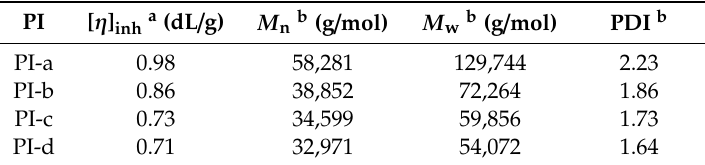
Table 1. Inherent viscosities and molecular weights of poly(amic acid) (PAAs). PI [ η ] inh a (dL / g) M n b (g / mol) M w b (g / mol) PDI b PI-a 0.98 58,281 129,744 2.23 PI-b 0.86 38,852 72,264 1.86 PI-c 0.73 34,599 59,856 1.73 PI-d 0.71 32,971 54,072